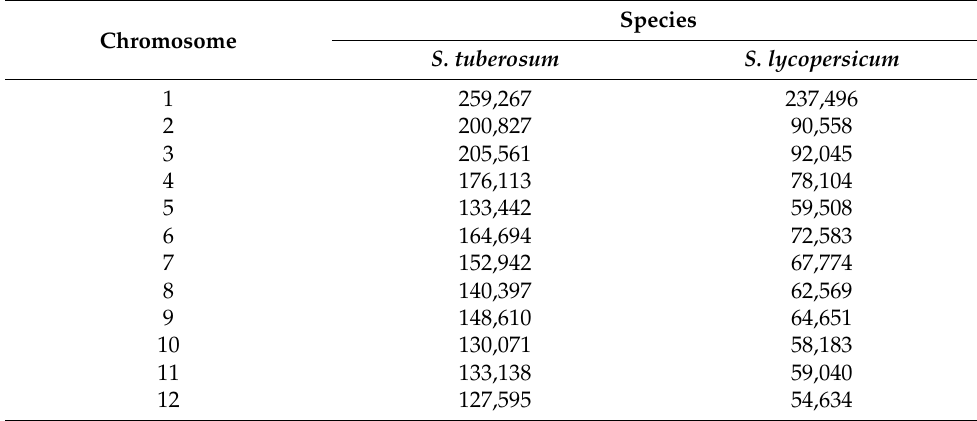
Table 4. Chromosome distribution of tree tomato variants with potato ( S. tuberosum ) and tomato ( S. lycopersicum